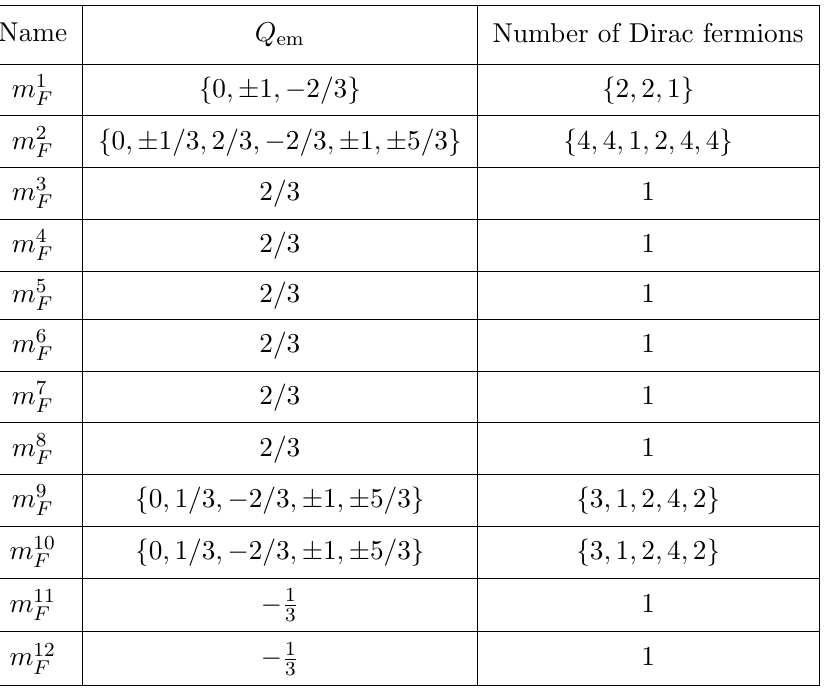
Table 3 . Spectrum of fermion resonances, partners of q L and u R of the third generation. m i generic name for all the fermions with the same mass. Where the electric charge is denoted with both signs, the amount of fermions in the third column is the sum of fermions with the positive charge and fermions with the negative charge. In those cases, the amount of fermions with a given sign in its electric charge is half the amount